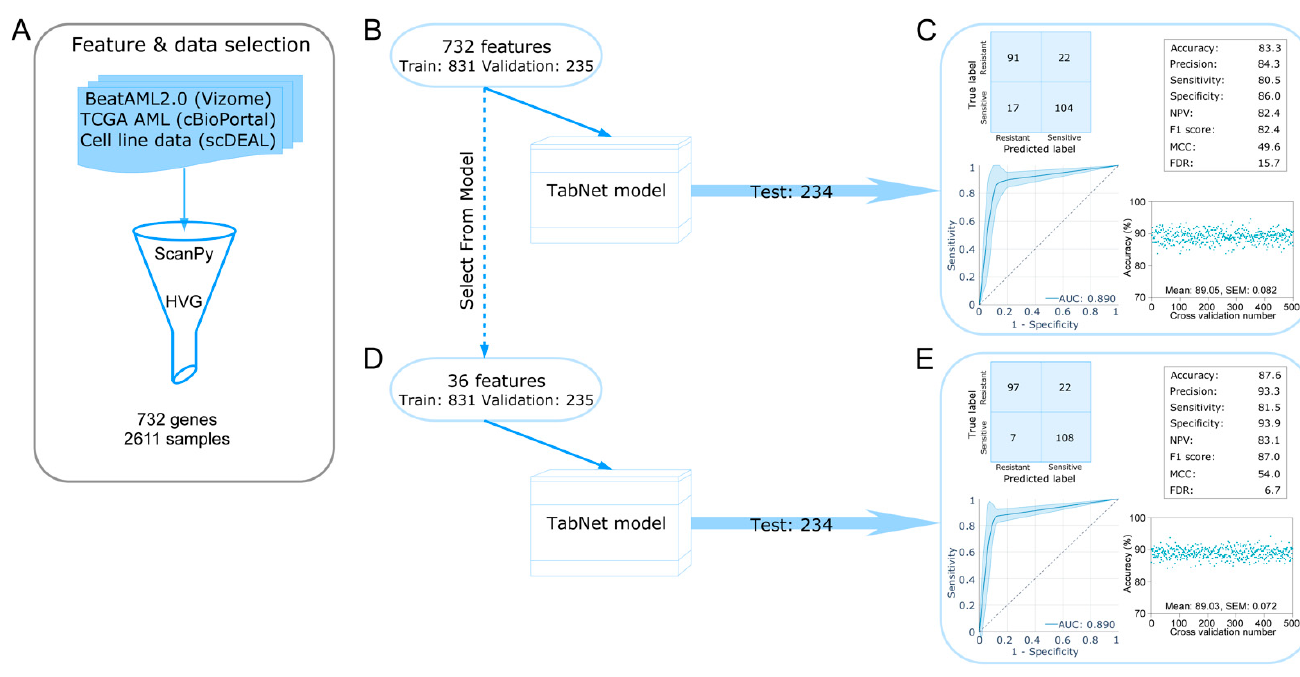
Figure 1. Development of deep learning models for tabular data. ( A ) Features were selected using the “highly variable genes” function from ScanPy. ( B ) Selected features (732) were used to develop a TabNet model. The model was built using 831 training samples and 235 validation samples and then was tested using 234 test samples. ( C ) The models’ performance was checked using a confusion matrix and several quality scores. Furthermore, from all samples (1300), we randomly sampled 20% of test samples 500 different times, and the rest of the 80% samples were used to build TabNet models. The ROC curve and accuracy scores represent results from all 500 tests. ( D , E ) A similar test was performed as described in ( B ) and ( C ) using 36 features selected using the “Select From Model” function from Sklearn feature selection.